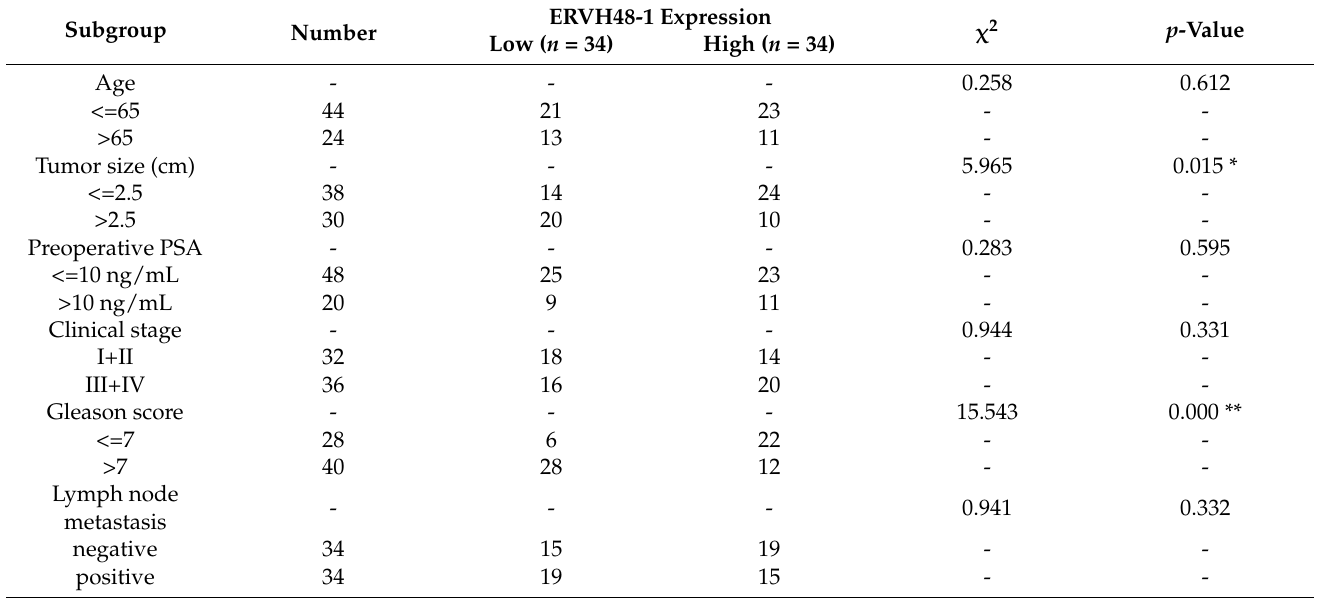
controls. Table 2 lists primers. The reaction used 95 degrees Celsius for 30 s, 40 cycles of 3 s, ∆∆ Ct and 60 degrees Celsius for 34 s. 2 − method assessed target gene expression. Table 2. Relationship between ERVH48-1 expression and clinical